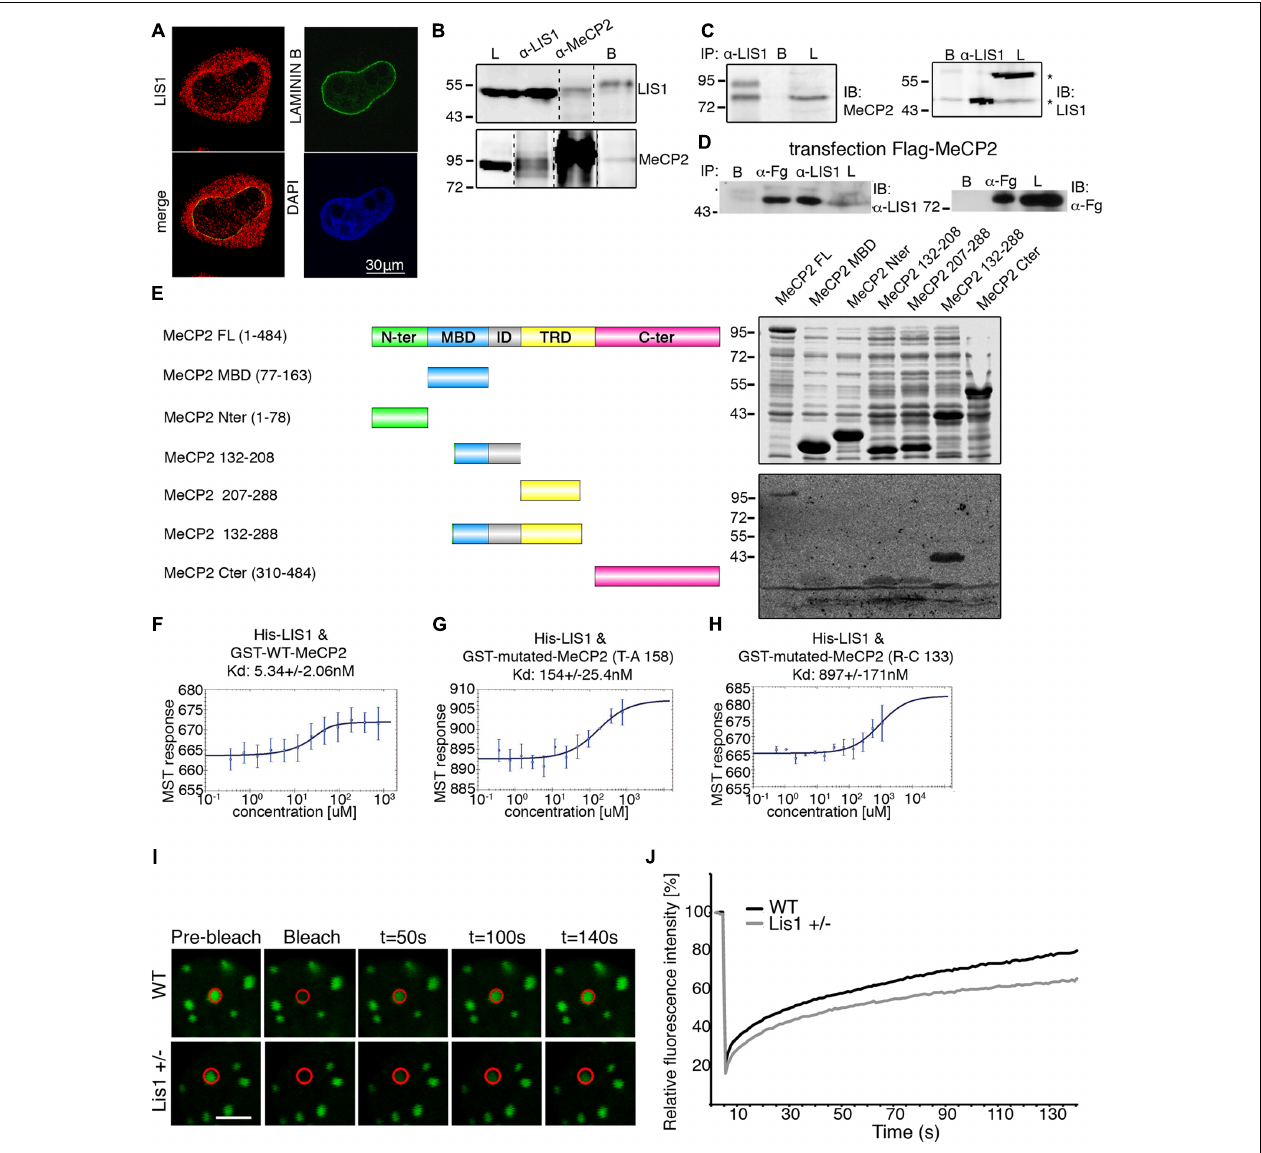
FIGURE 1 | LIS1 and MeCP2 interaction. (A) Nuclear localization of LIS1. HeLa cells were fixed and immunostained for LIS1 (Ab210, red) and Lamin B (green). DNA was stained with DAPI (blue). (B) Co-IP of LIS1 and MeCP2 from cross-linked P1 brains lysates. P1 mouse brains were fixed in 1% PFA, sonicated and immunoprecipitated using anti-LIS1 or anti-MeCP2 antibodies. Western blot analysis of the lysates (L), respective immunoprecipitations, and control beads (B) is presented. (C) Anti-LIS1 antibodies immunoprecipitated endogenous MeCP2 from mouse brain nuclei. (D) Anti-FLAG (Fg) antibodies immunoprecipitated flag-tagged MeCP2 from transfected HEK293 cells and co-immunoprecipitated endogenous LIS1. (E) LIS1 interacts directly with MeCP2 in a defined tandem repeat domain in vitro . Recombinant full-length (FL) or indicated fragments of MeCP2 were expressed in bacteria. Bacterial lysates were separated by SDS-PAGE, the gels were either Coomassie-blue stained (top box) or subject to Far-western analysis (bottom box). MeCP2 fragments (132–208, 207–288, and 132–288) bind to LIS1, note the stronger signal with the fragment containing the tandem repeat (132–288). (F,G) Microscale Thermophoresis (MST) interaction analyses of LIS1 with MECP2. Fluorescently labeled His-LIS1 was incubated with increasing concentrations of recombinant MeCP2, wild-type (F) , T158A (G) , R133C (H) . The MST response was used to calculate the indicated dissociation constants (Kd). (I,J) FRAP analyses of MeCP2-GFP in WT or Lis1 ± cortical neurons. (I) Representative images of bleached cells in which the bleached region is marked by a red circle. (J) Relative average fluorescence intensity over time ( n = 24), Ctl black line, Lis1 shRNA gray line. The scale bar is 5 mm.